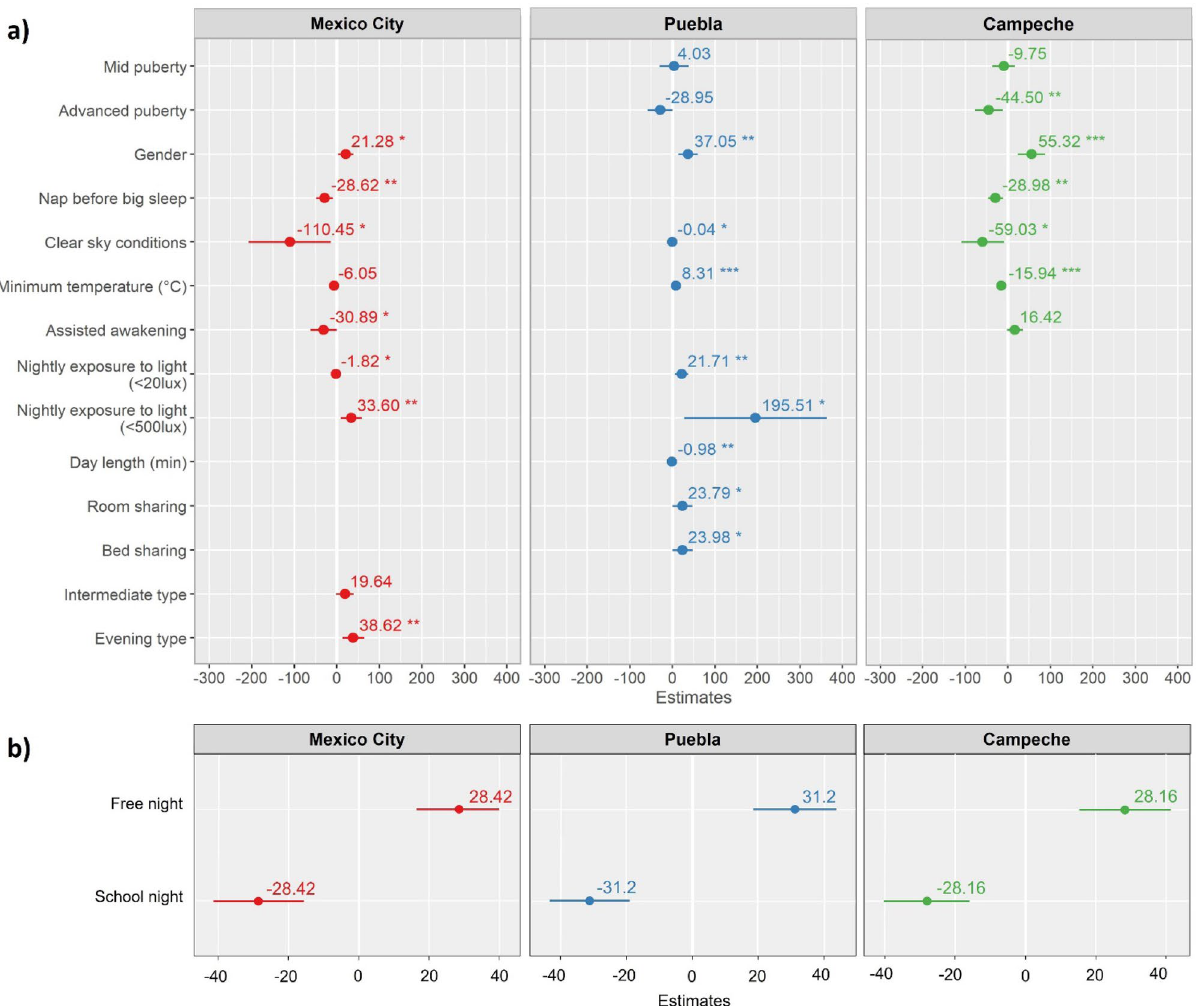
Figure 2. Effect sizes for site-specific multilevel models. ( a ) Estimates for fixed effects (i.e., predictor variables with a constant effect on the individuals’ sleep duration). ( b ) Estimates for random effects (i.e., weeknight-level variation on sleep